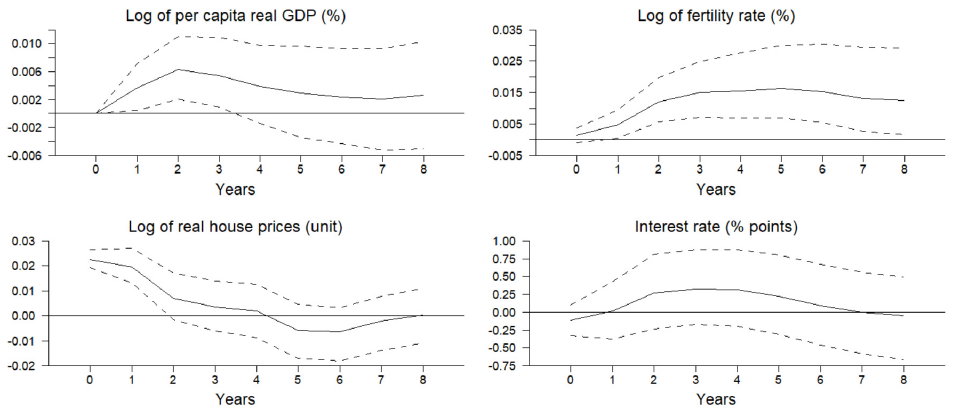
Figure 10. Responses to a house price shock in the baseline SVAR when the fertility rate is ordered last in the model .